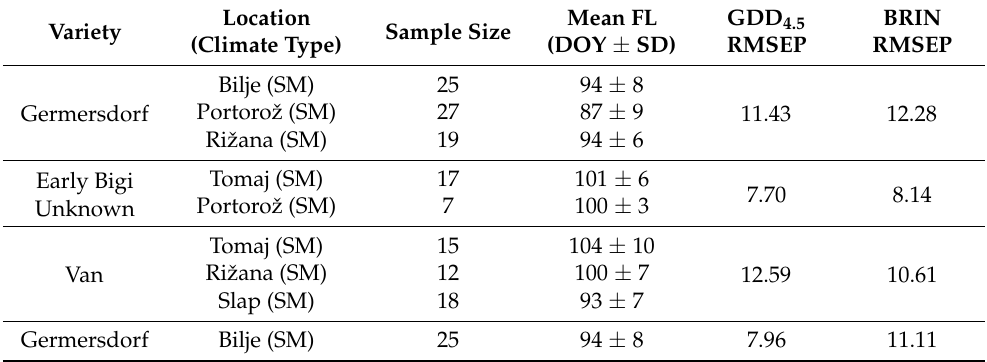
Table A2. Mean and standard deviation of observed historical flowering dates for the available sample sizes of several sweet cherry varieties, and the performance of GDD and BRIN models in modeling flowering dates. The assessment was made by calculating the root mean square error of prediction (RMSEP) and index of agreement (d) for the modeled and observed flowering dates. In both models, the base temperature is T b = 4.5 ◦ C.